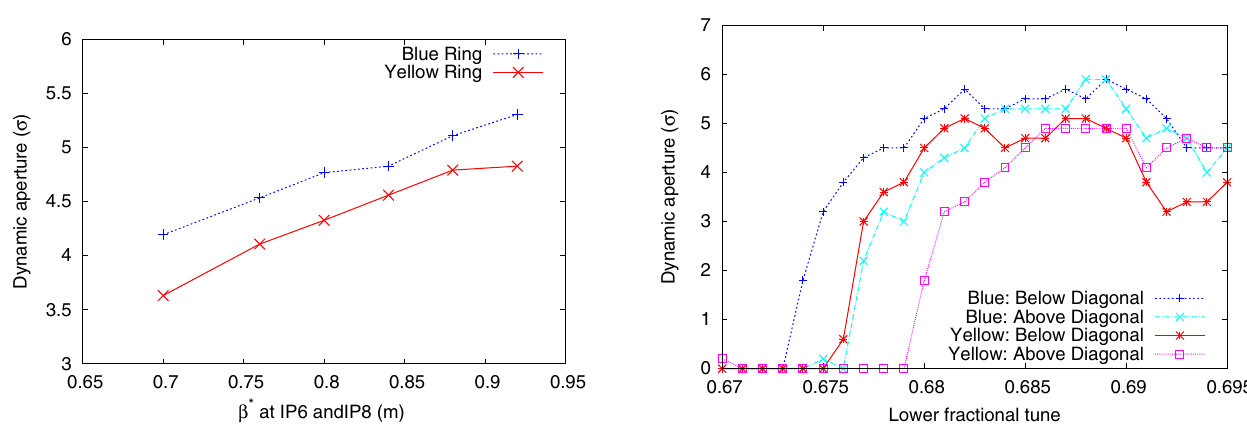
FIG. 21. Calculated dynamic aperture in tune scans above and below the diagonal line. The horizontal tune is the lower lattice